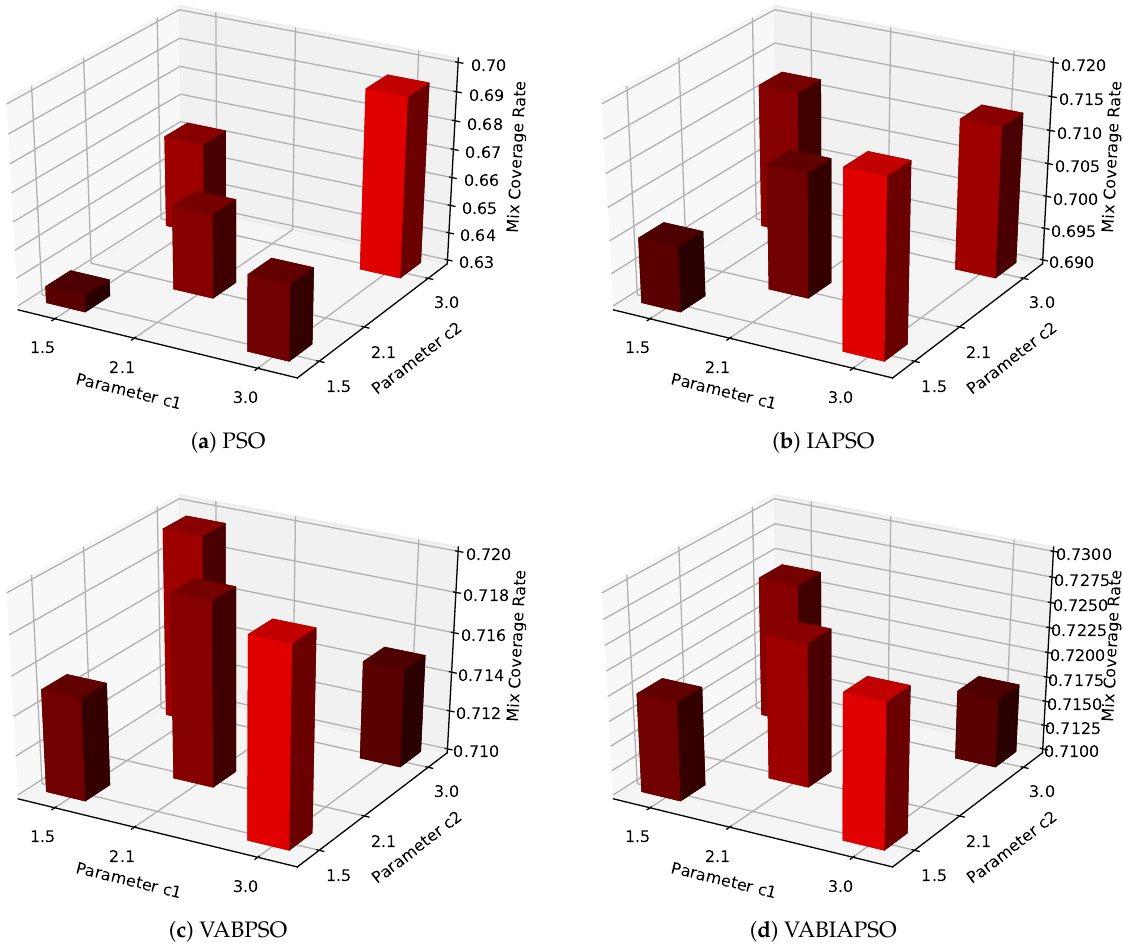
Figure 11. The mix coverage of the four algorithms under different values of C 1 and C 2 in the real